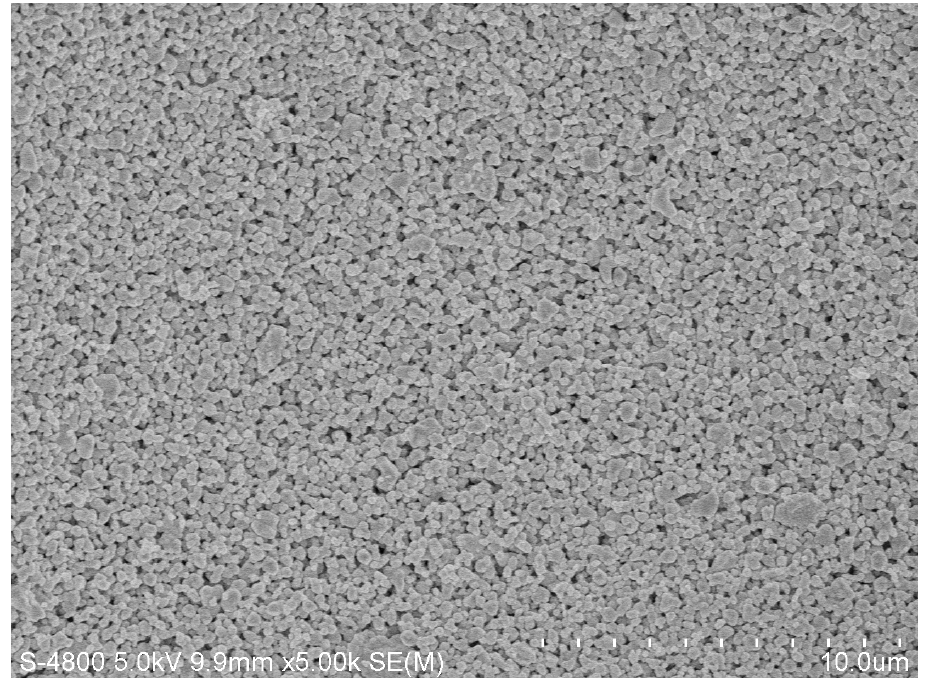
membrane, magnification 2